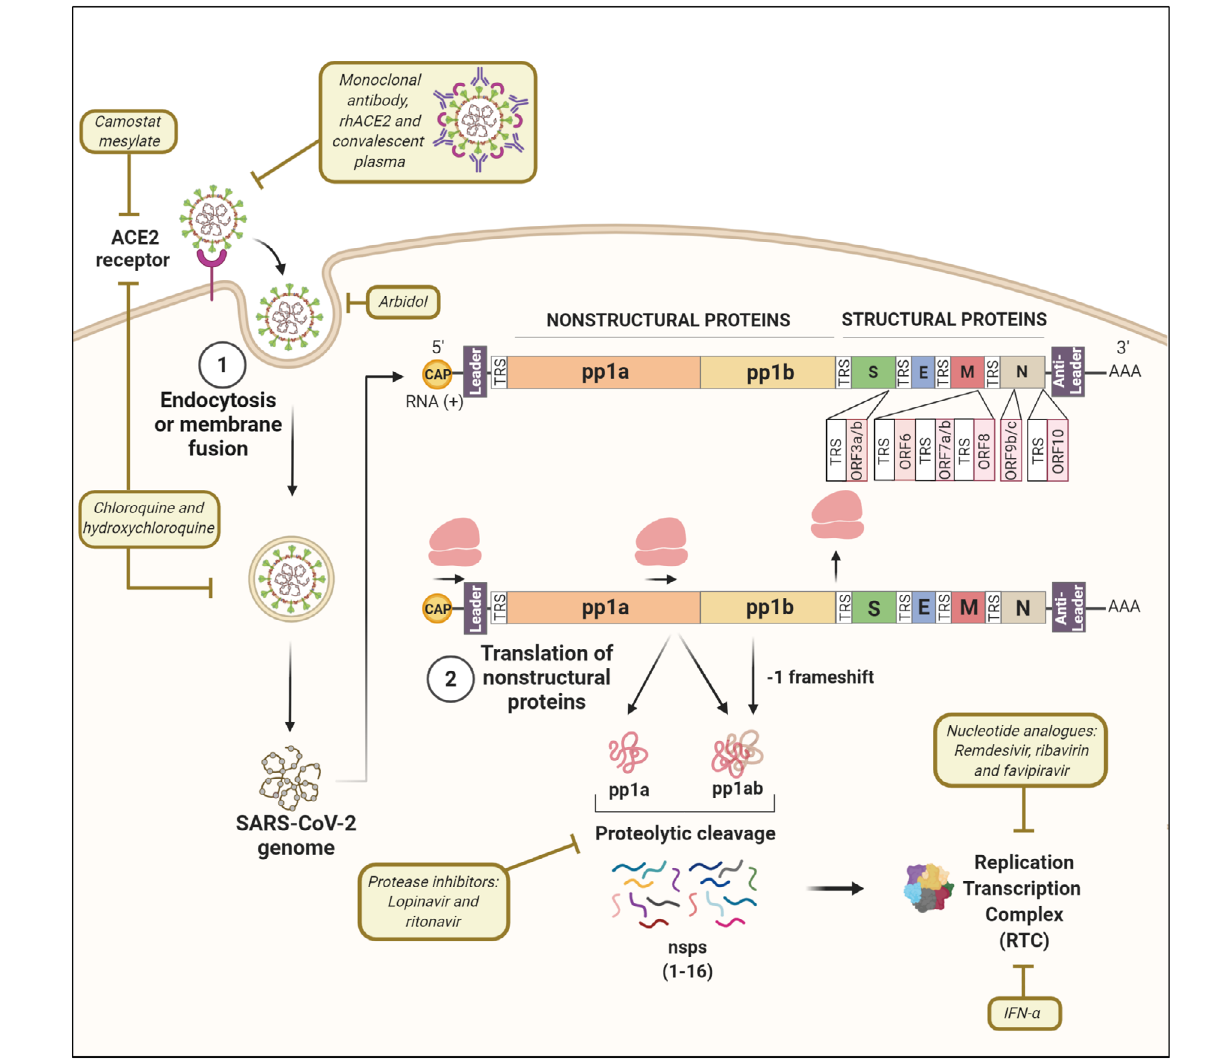
Figure 1 – Molecular mechanisms related to the production of non-structural proteins (nsps) and assembly of the SARS-CoV-2 replication and transcription complex (RTC). Process 1: after recognition of the ACE2 (Angiotensin Converting Enzyme 2) cell receptor, the viral nucleocapsid is released into the cytoplasm by endocytosis, or fusion of the viral envelope, with the cell membrane. Process 2: the translation of the pp1a and pp1b genes from the 5’-capped and 3’-polyadenylated genome (+) of the virus produces the pp1a or pp1ab polyproteins, the latter being generated by a -1 frameshift of ribosomes. These polyproteins are then cleaved by viral proteases generating 16 virus nonstructural proteins (nsps), some of which are used to assemble the RTC, including the RNA-dependent RNA polymerase (RdRp or nsp12). Pharmacological interventions targeting specific points of the replication cycle of coronaviruses are highlighted. RTC: Replication and transcription complex; RdRp: RNA-dependent RNA